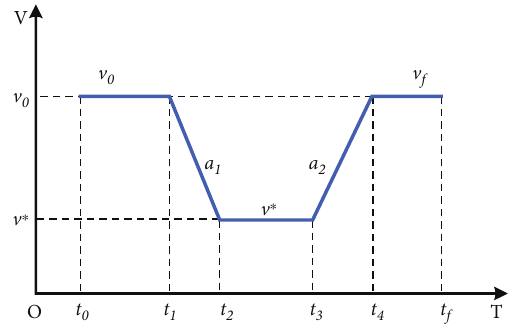
Figure 2: Entire process of speed planning. Table 1: Weighting parameters of two driving modes.